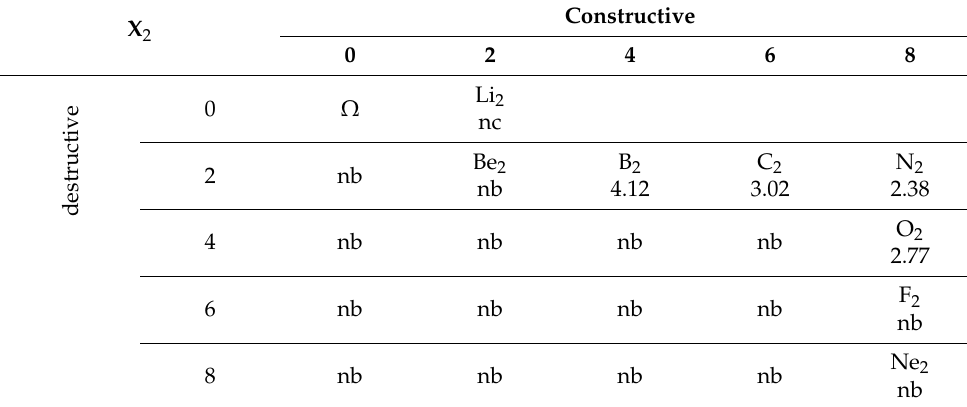
Table 2. Equilibrium bond distances for the second-row homonuclear dimers from OF-DFT using the deformation potentials in accordance with molecular orbital (MO)